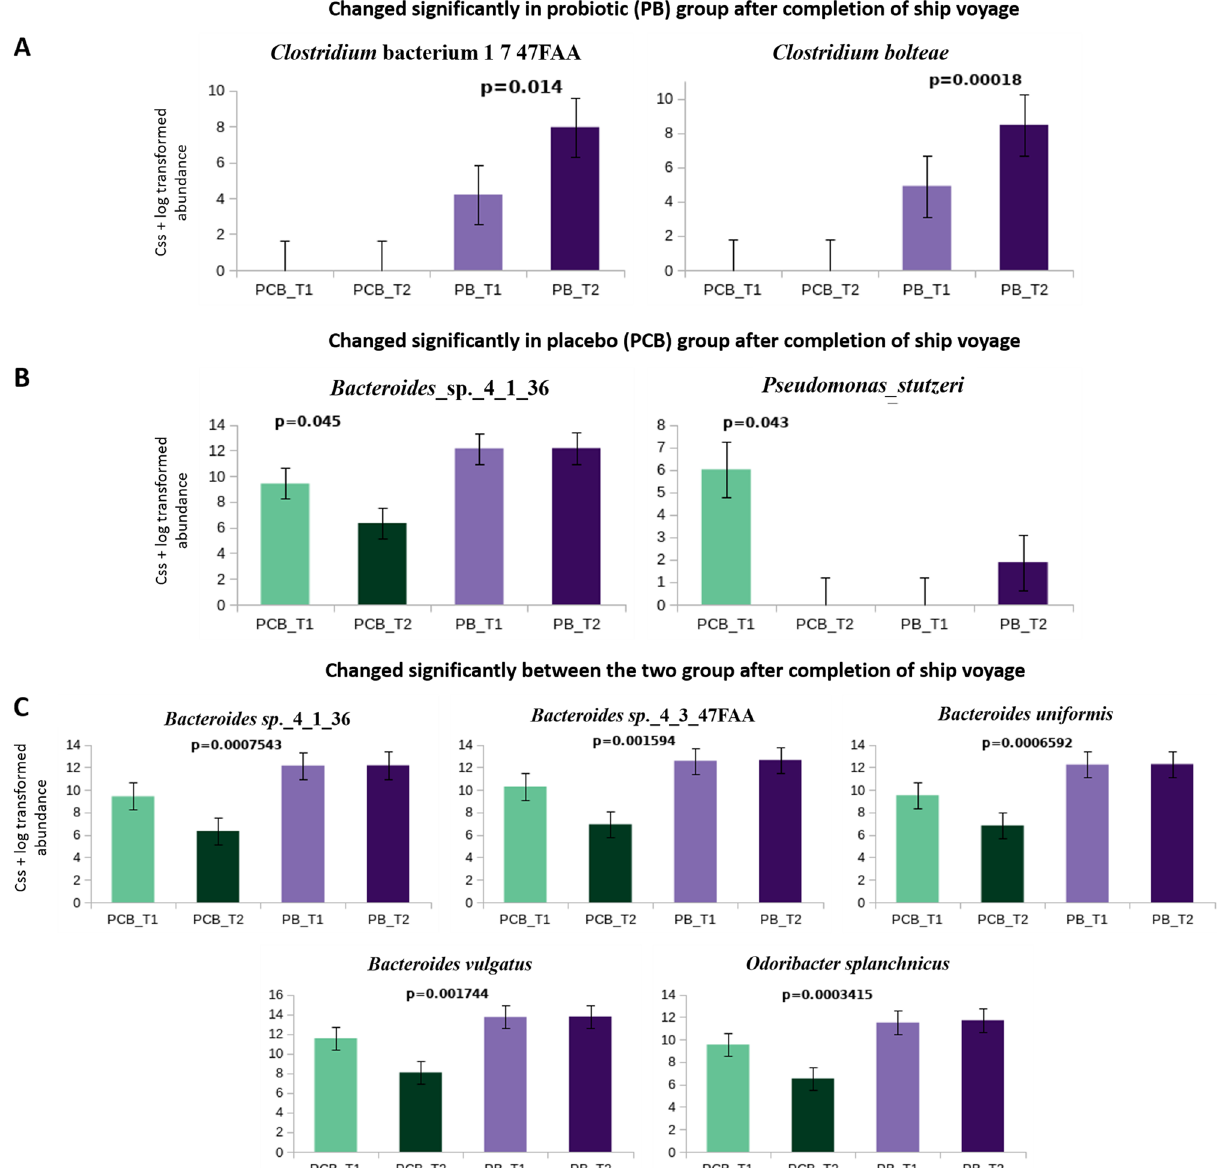
Figure 3. Taxonomic composition (css + log transformed) at species level. A - At baseline, the species did not have a significant difference between PCB and PB groups, but changed significantly in PB group at the end of ship voyage. B - The species changed significantly only in PCB group during the ship voyage. C - The species abundance changed significantly between PCB and PB groups after completion of the ship voyage (PCB_T2 and PB_T2). p -value < 0.05 was considered to be statistically significant (Wilcoxon rank-sum tests) using in-house R-script. Error bar represents standard error mean